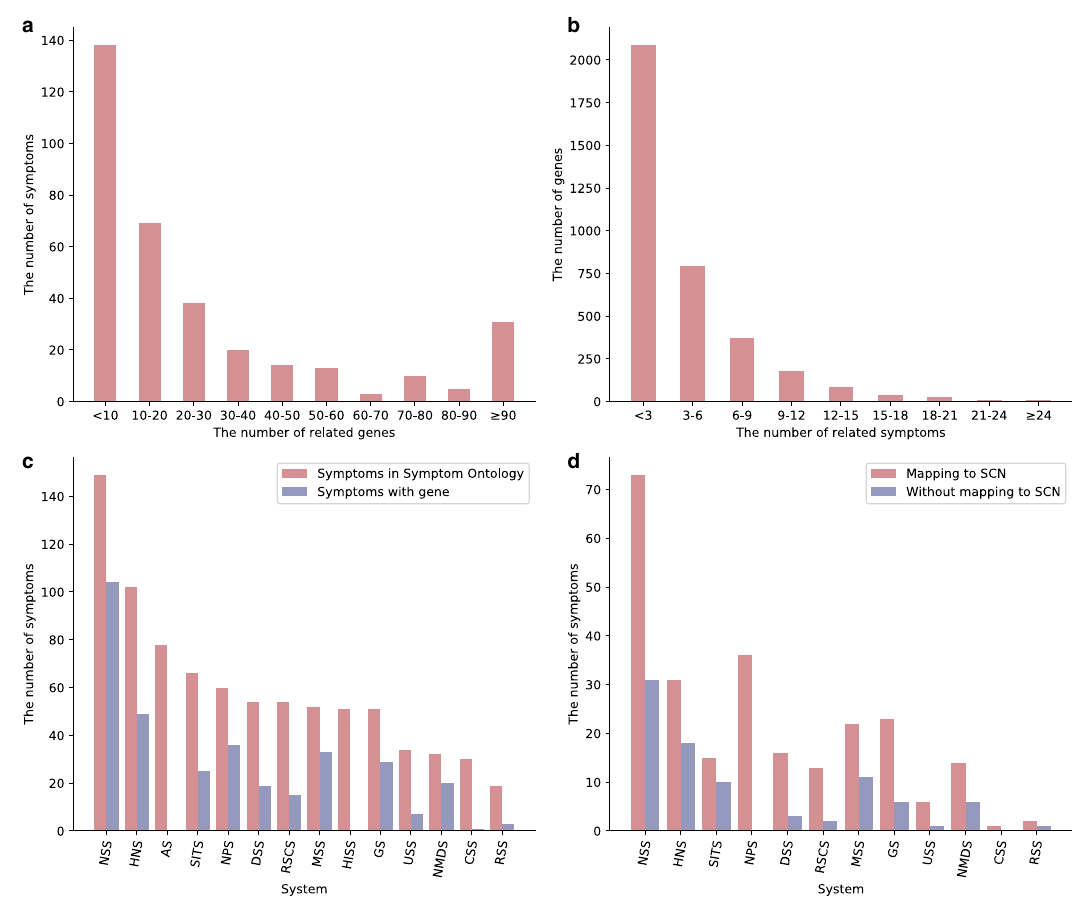
Fig. 2 The basic statistics of high-quality symptom-gene associations. a The distribution of symptom-related genes. b The distribution of gene-related symptoms. c The distribution of related system categories of symptoms. We compared the class information of symptoms with gene information to the ontology. d Mapping distribution of symptoms with genetic information to SCN. We compared the different system categories of symptoms with genes information grouped by mapping to SCN. The full name of the system: NSS Nervous System Symptom, HNS Head and Neck Symptom, AS Abdominal Symptom, SITS Skin and Integumentary Tissue Symptom, NPS Neurological and Physiological Symptom, DSS Digestive System Symptom, RSCS Respiratory System and Chest Symptom, MSS Musculoskeletal System Symptom, HISS Hemic and Immune System Symptom, GS General Symptom, USS Urinary System Symptom, NMDS Nutrition, Metabolism, and Development Symptom, CSS Cardiovascular System Symptom, RSS Reproductive System